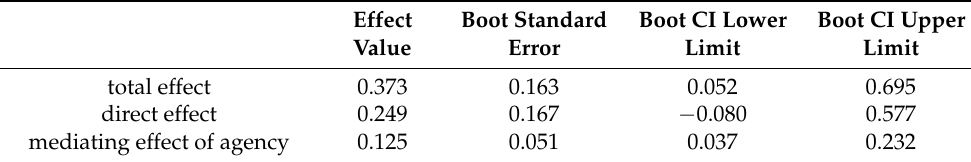
Table 4. Decomposition of the total, direct, and mediated